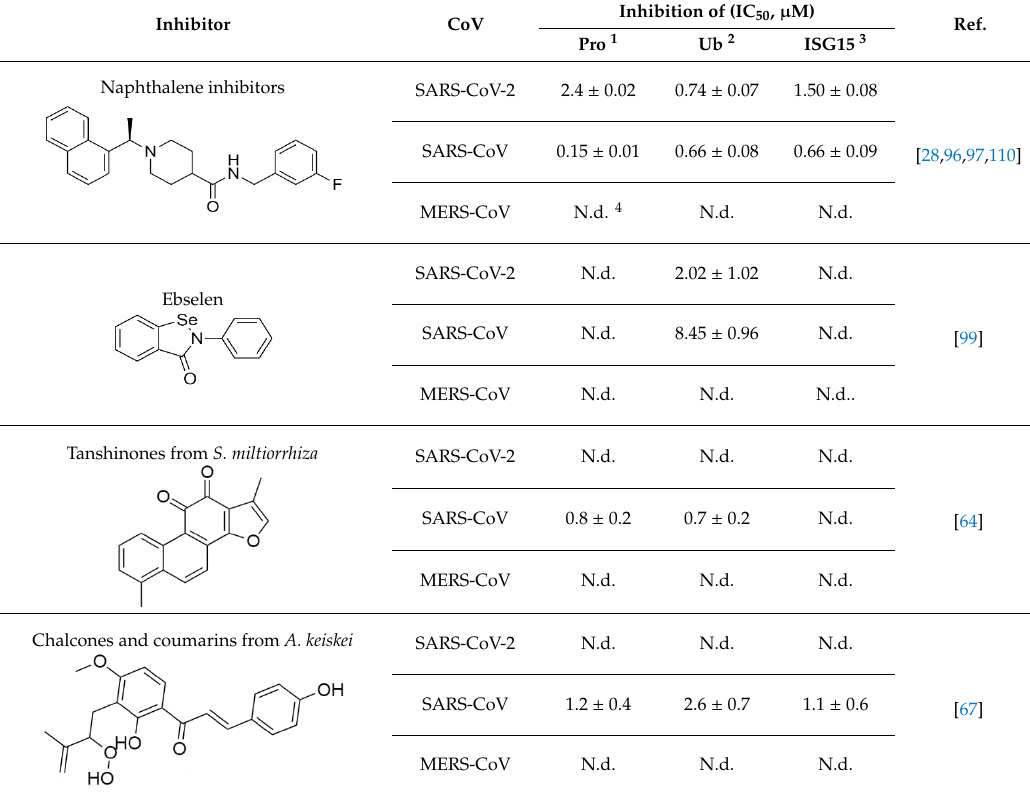
Table 2. Inhibitors for CoV PLpro.